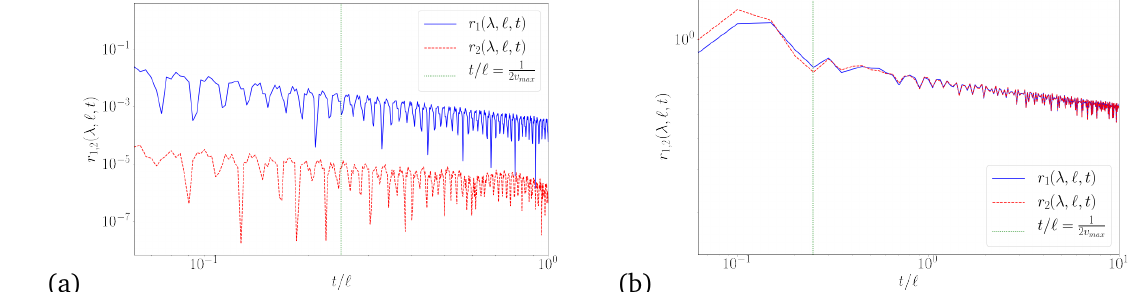
( λ = 0.1, (cid:96) = 200, t ) for a quench within the ferro- 1,2 = 0 to h = 0.8. (b) same for r 0